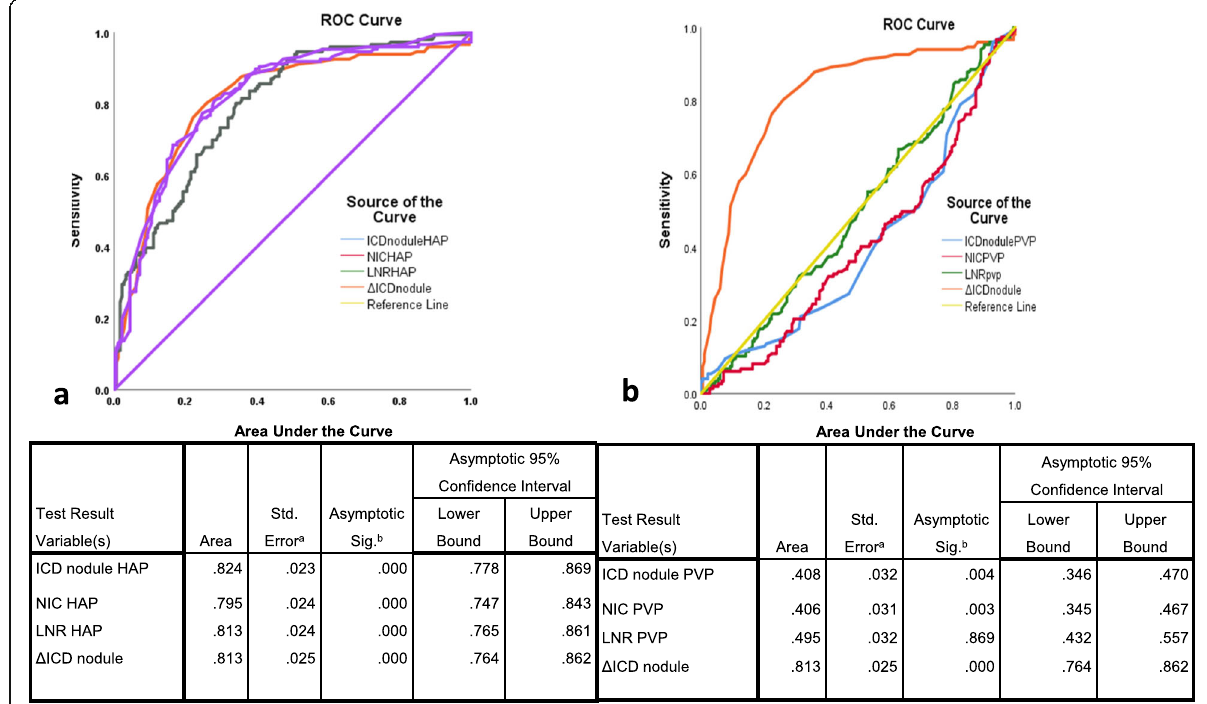
Fig. 5 Receiver operating curves of material density parameters with area under curve, sensitivity, and specificity of each parameter as tabulated below. a ROC curves plotted on HAP. b ROC curves plotted on